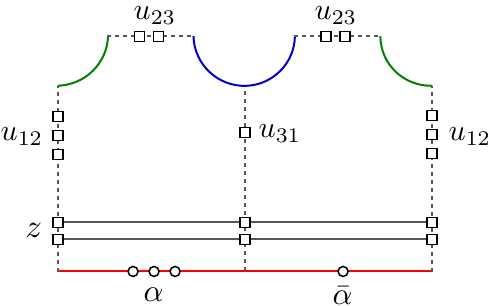
Figure 13 . Wrapped hexagons at higher wrapping orders. Our analysis shows that a proper treatment of the divergences plaguing the bare hexagon expansion results in the introduction of \wrapping magnons", here depicted as straight lines at the bottom of the (cid:12)gure. They live close enough to the edges not to be de(cid:13)ected as they cross the hexagons but can nonetheless in(cid:13)uence the physics taking place in the bulk of the pair of pants. They are like thermal loops sourced by the half in(cid:12)nite tube representing the operator. We can have con(cid:12)gurations involving any number of bulk and wrapping magnons at the same time. The expectation is that the latter will thermalize the former, resulting in some sort of TBA dressing of the bare hexagon